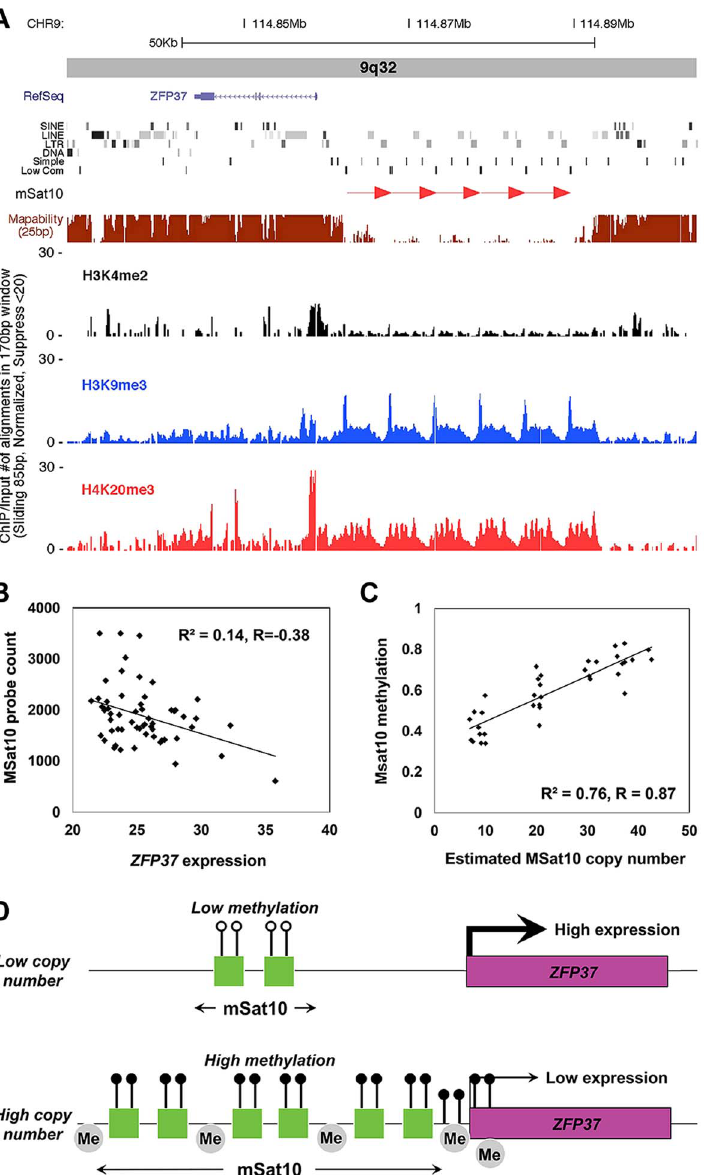
Figure 5. Association of MSat10 copy number with neighboring gene expression and epigenetic marks. ( a ) MSat10 is a 5.2 kb GC-rich tandem repeat that lies , 4 kb distal to the gene ZFP37 . Although 6 copies of this 5.2 kb repeat are present in the hg18 assembly this macrosatellite is highly polymorphic in size, varying from 4–42 copies in HapMap. ChIP-seq analysis shows the presence of histone marks characteristic of heterochromatin, such as trimethylation of histone H3 at lysine 9 and trimethylation of histone H4 at lysine 9. Screenshot from the UCSC Genome Browser shows ZFP37 (Zinc Finger Protein 37), the adjacent MSat10 repeat ( red arrows ), and the results of ChIP-seq analysis. ( b ) In 58 unrelated CEU HapMap individuals we observed an inverse correlation between copy number of the MSat10 repeat and expression level of the adjacent gene ZFP37 , demonstrating suppression of ZFP37 expression associated with larger repeat sizes ( c ) Using a targeted Sequenom assay, we confirm that variable methylation of MSat10 is highly correlated with repeat number (R 2 =0.76, p=4.4 6 10 2 12 ), showing a strong relationship between repeat size and local epigenetic state. ( d ) Proposed model of repeat induced gene silencing at the MSat10 locus. At low repeat numbers the region is euchromatic and the expression of the neighboring ZFP37 gene is high. However, expansions of the macrosatellite result in an accumulation of heterochromatic marks in the region, including repressive histone modifications and DNA methylation, resulting in the suppression of local gene expression. Although our model shows methylation on all MSat10 copies, our data does not exclude the possibility that on expanded MSat10 alleles DNA methylation is limited to a subset of the repeat units. Lollipops represent DNA methylation, with open circles being low and filled black circles high DNA methylation, and grey ‘Me’ bubbles represent repressive histone